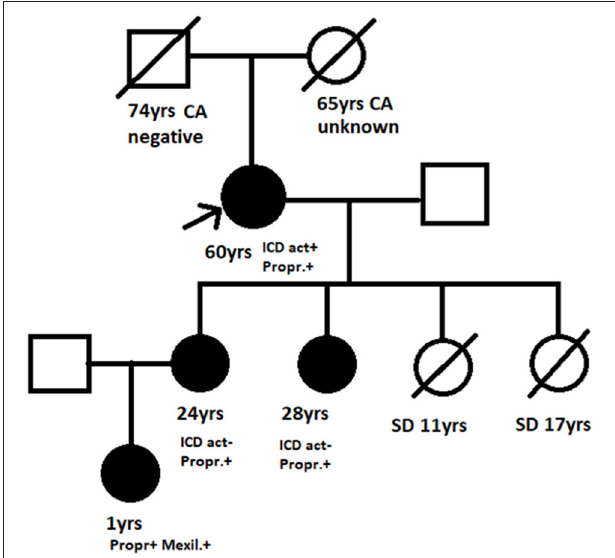
FIGURE 3 | Family pedigree. Arrow, Proband; black filled symbols, Affected Y1795C mutation carrier; SD, Sudden death; CA, Cancer; negative/unknown, Y1795 mutation status; ICD, Intracardiac defibrillator; act ± , History of appropriate activation yes/no; Propr. + , Mexil. + , Propranolol/mexiletine